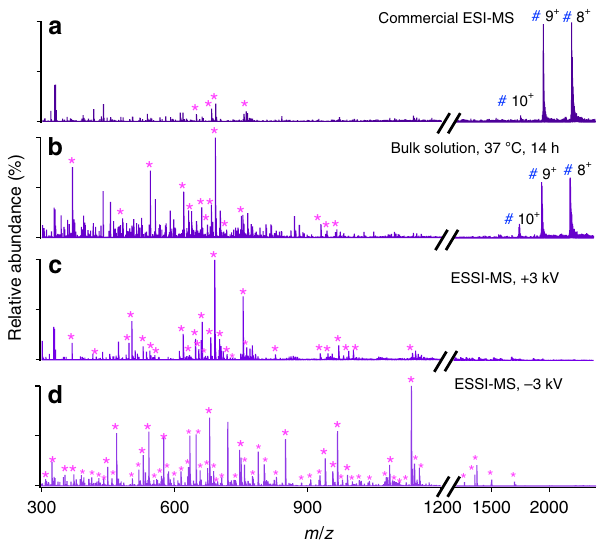
Fig. 4 Mass spectra of myoglobin digestion with various methods. a Commercial ESI-MS (LTQ Orbitrap Elite, Thermo Scienti fi c), b bulk phase at 37 °C for 14 h, followed by analysis with commercial ESI-MS, and ESSI- MS applied with c a positive high voltage ( + 3 kV), and d a negative high voltage ( − 3 kV). Magenta asterisks denote the peptide fragments, and blue #s mark undigested myoglobin